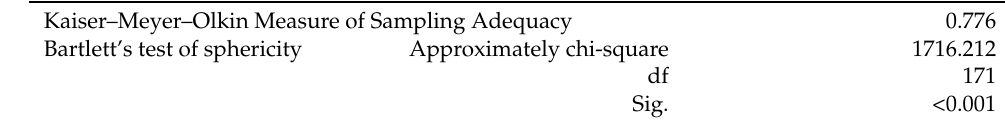
Table 3. KMO and Bartlett